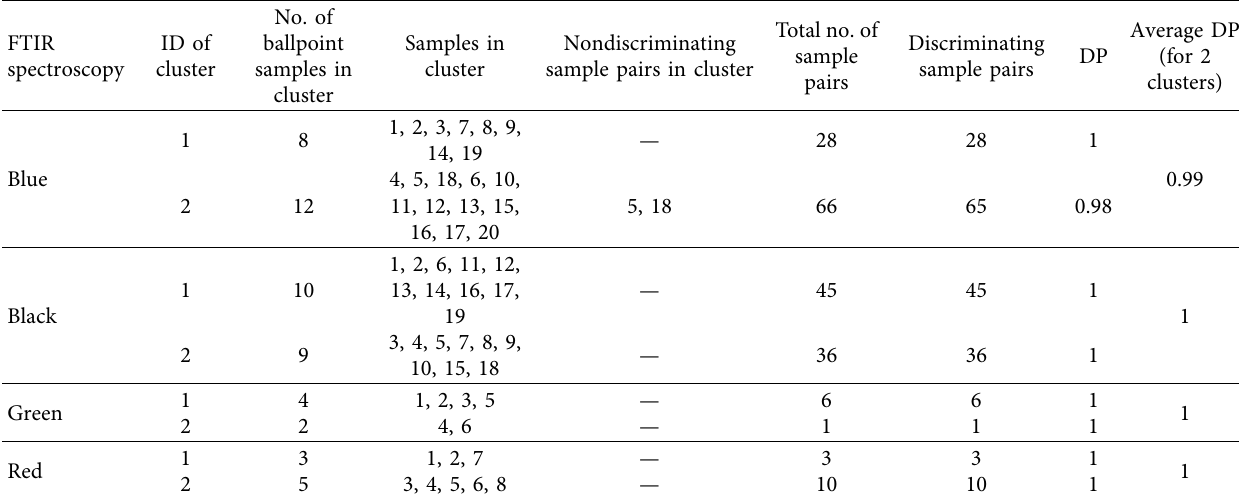
FTIR: Fourier transform infrared spectroscopy; DP: discriminating